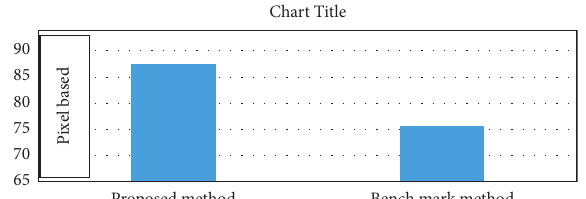
Figure 12: It shows the comparison of experimental results of all